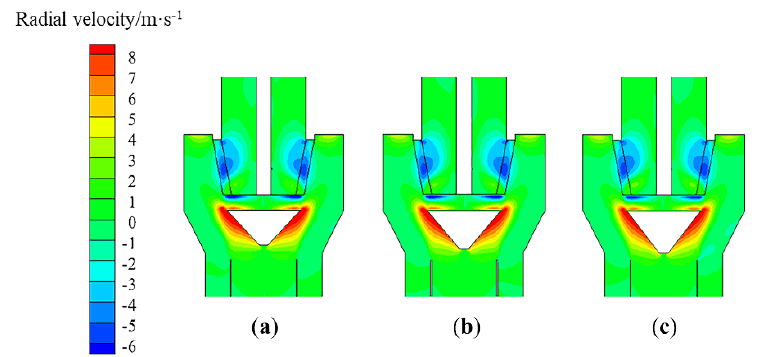
Figure 16. Effect of the height of the diversion cone on the radial velocity (T-C (1-0.8) , x = 0): ( a ) h = 94 mm, ( b ) h = 104 mm, and ( c ) h = 114 mm.